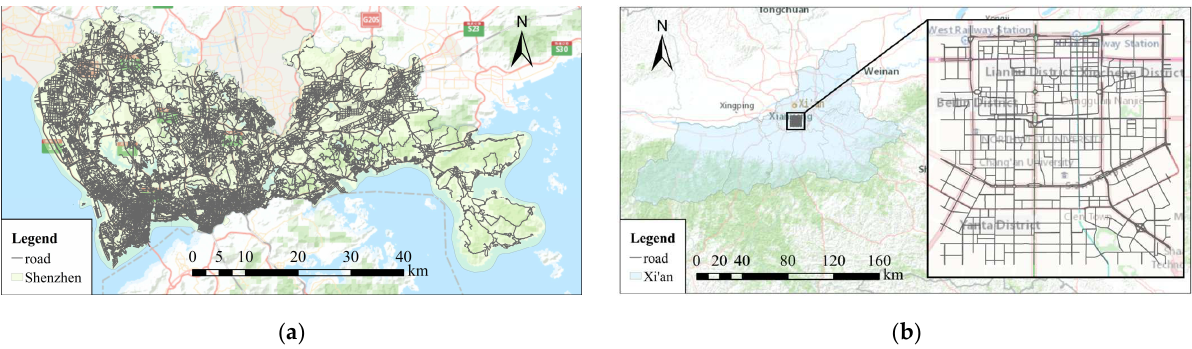
Figure 5. The study area and the corresponding road network of ( a ) Shenzhen dataset and ( b ) Xi’an dataset.